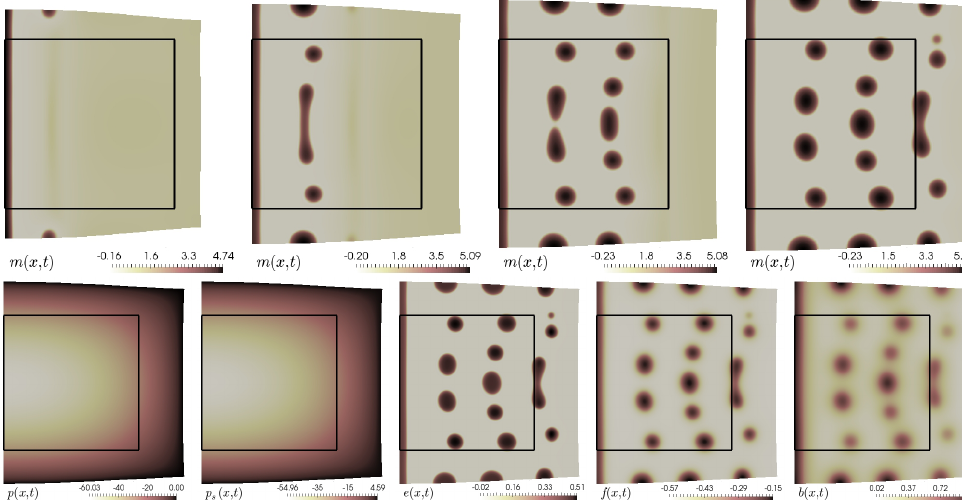
Figure 7. Evolution of the mesenchymal cell concentration under finite growth using the formu- lation (30), snapshots are taken at t = 160,280,400,520 (first row). Bottom: plots at t = 520 of fluid pressure, solid pressure, epithelium, FGF, and BMP. Mechano-chemical coupling governed by ξ f = 0.5.